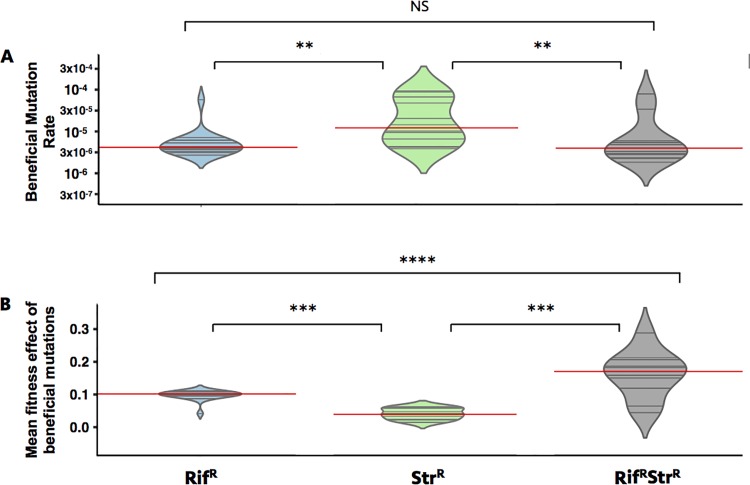
Compensatory mutations have stronger effects in double-resistant mutants.Estimates of the rate of acquisition of beneficial mutations (A) and mean selective effects (B) of arising beneficial mutations are shown in the violin plots and correspond to the distribution of the top 20 simulations, from the inference algorithm in the One Bi-Allelic Marker Algorithm (OBAMAv2), that best explain the experimental data. Red lines indicate the median of the distributions. NS, non-significant, **p < 0.01 and ****p < 0.0001 in a two-sample Kolmogorov test for comparing the distributions, adjusted for multiple comparisons using the Benjamini and Hochberg method [38].